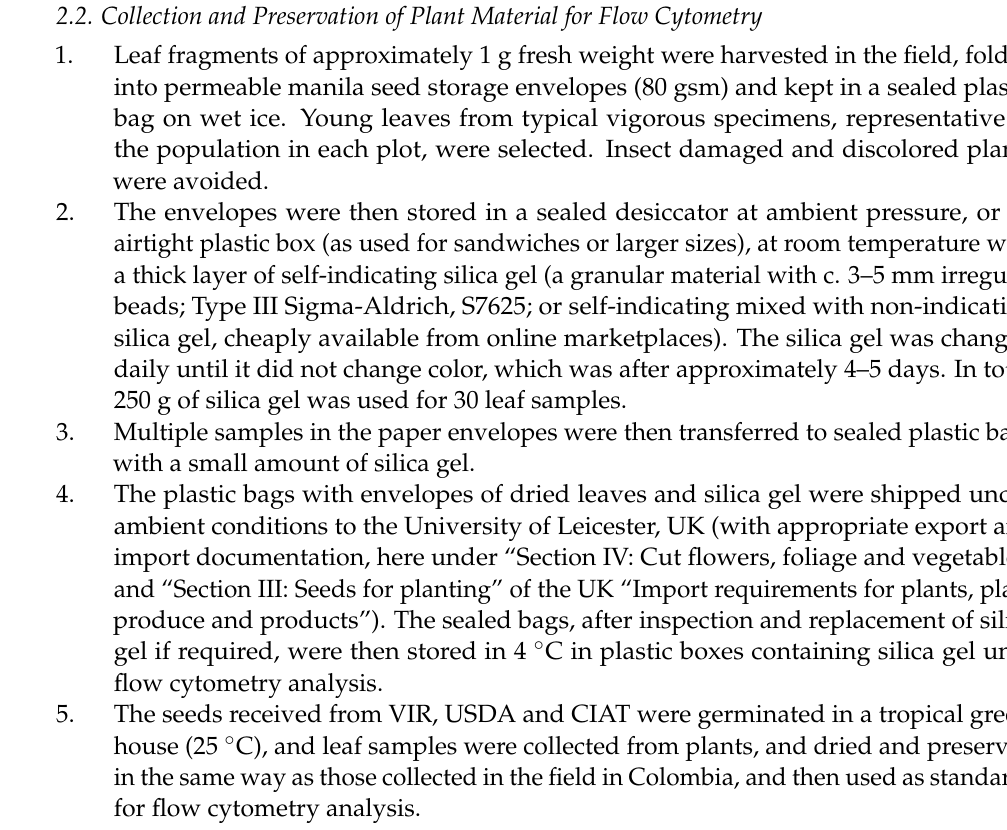
Figure 1. Field plots of Urochloa tropical forage grasses in CIAT, Colombia.